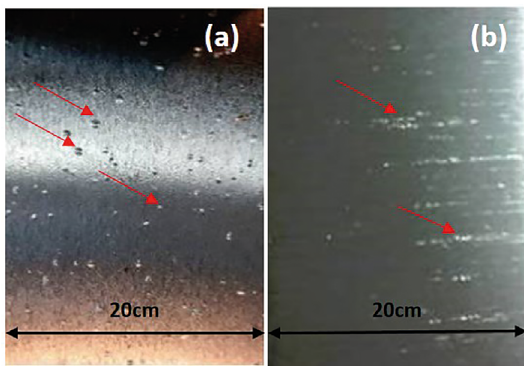
Figure 1. a) Bubble-type flaw on a hot rolled AA5052 alloy (final sheet thickness: 9.52mm), b) scale-type flaw on a cold rolled AA5052 alloy (final sheet thickness: 3.20mm)